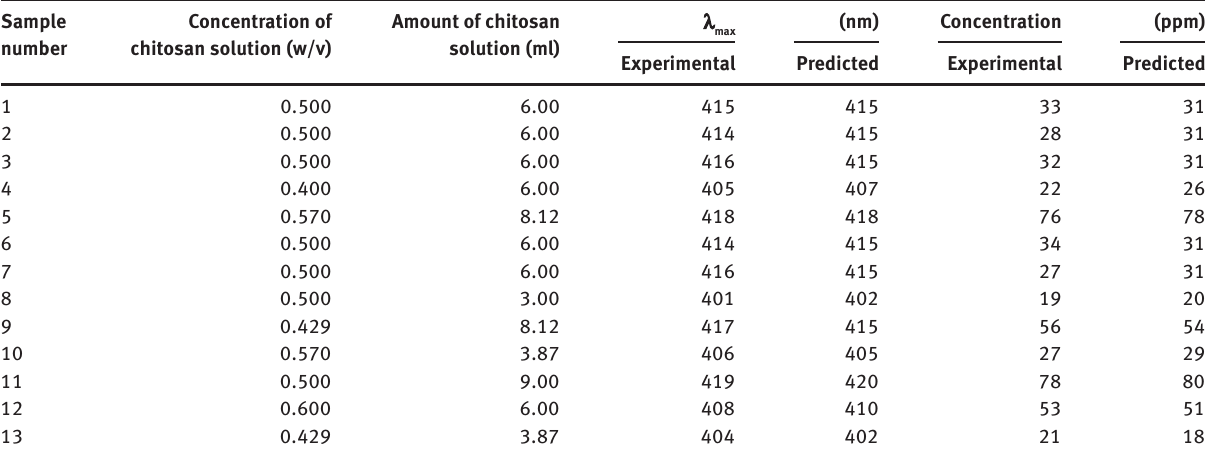
Table 1: Central composite design (CCD) and response variables for synthesis of silver nanoparticles (AgNPs). Sample number